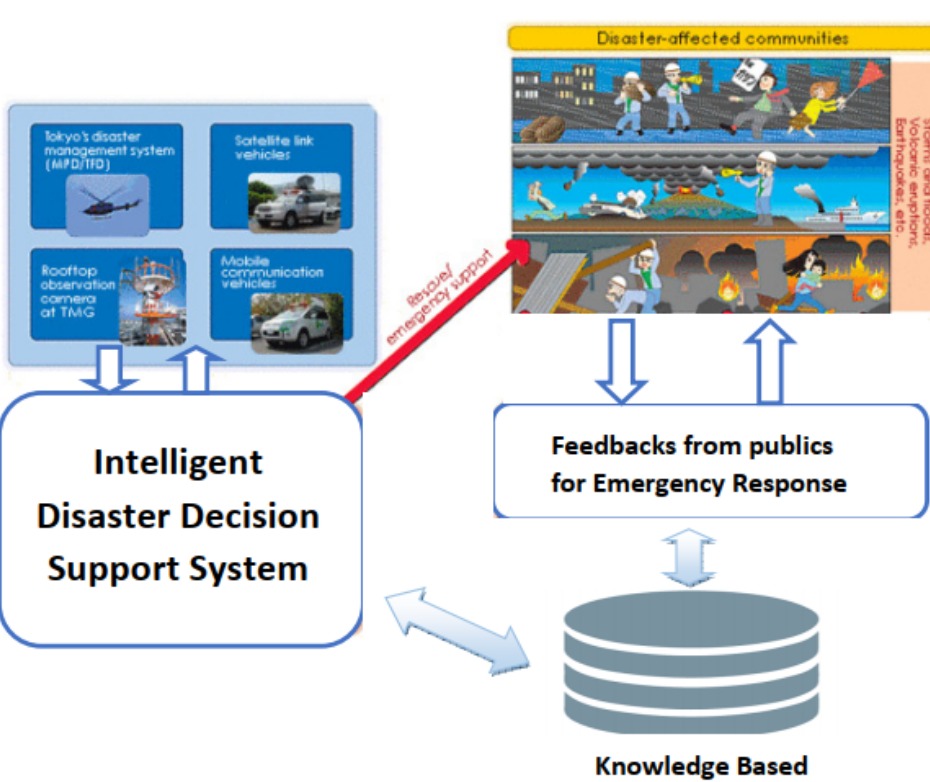
Figure 2. Overview of the proposed system using the Internet-of-Things (IoT). A conceptual view of the proposed system to implement emergency